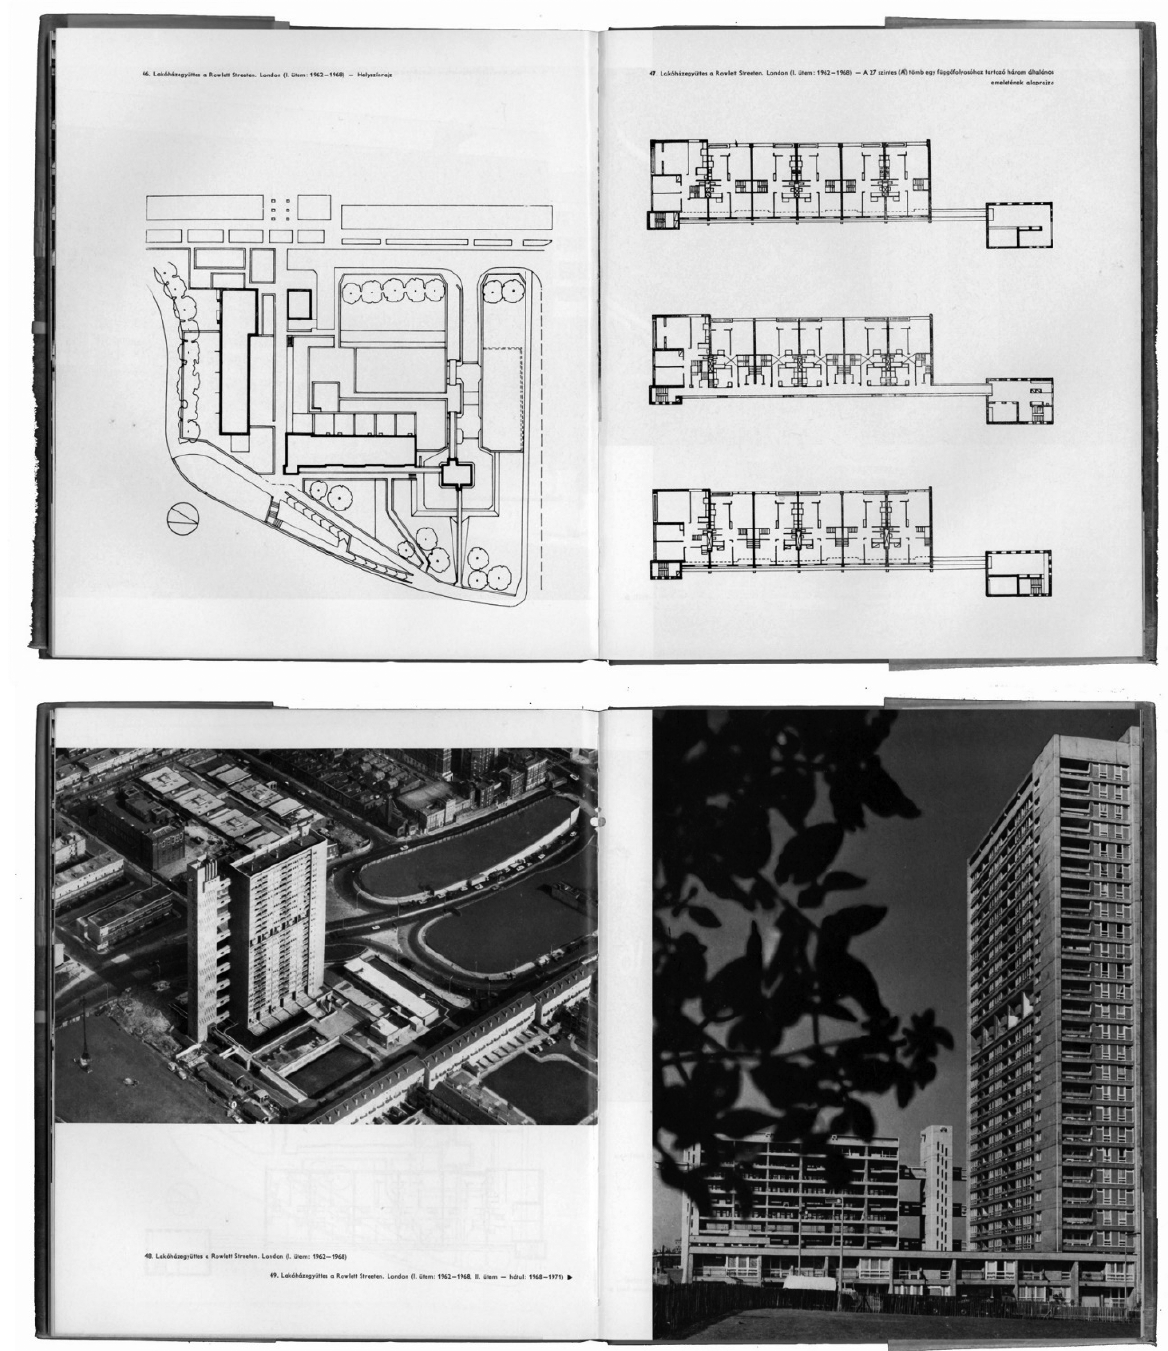
Figure 3. Major M. (1973), Goldfinger Ernő , Akadémiai Kiadó, Architectura sorozat, Budapest. The imposing bulk of the buildings, marked by homoge- nous materials and the repetition of equal modules, con- veys the martial image of a fortress that stands out with its compact presence against a formless part of the city, where Victorian row houses alternate with empty spaces, infrastructures and industrial